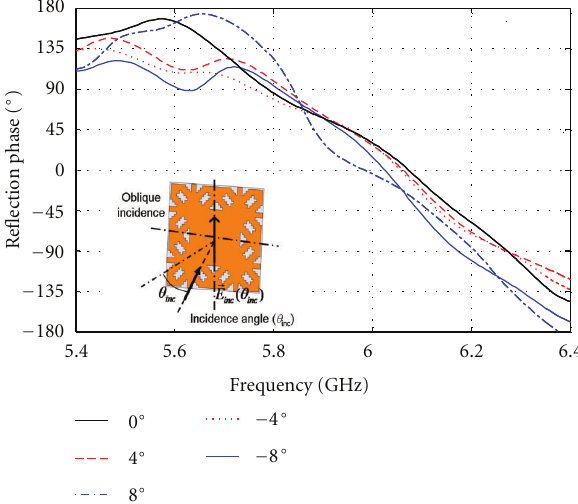
Figure 7: Reflection phase of the manufactured prototype for di ff erent incident field ( E inc ) polarization angles ( ϕ ).